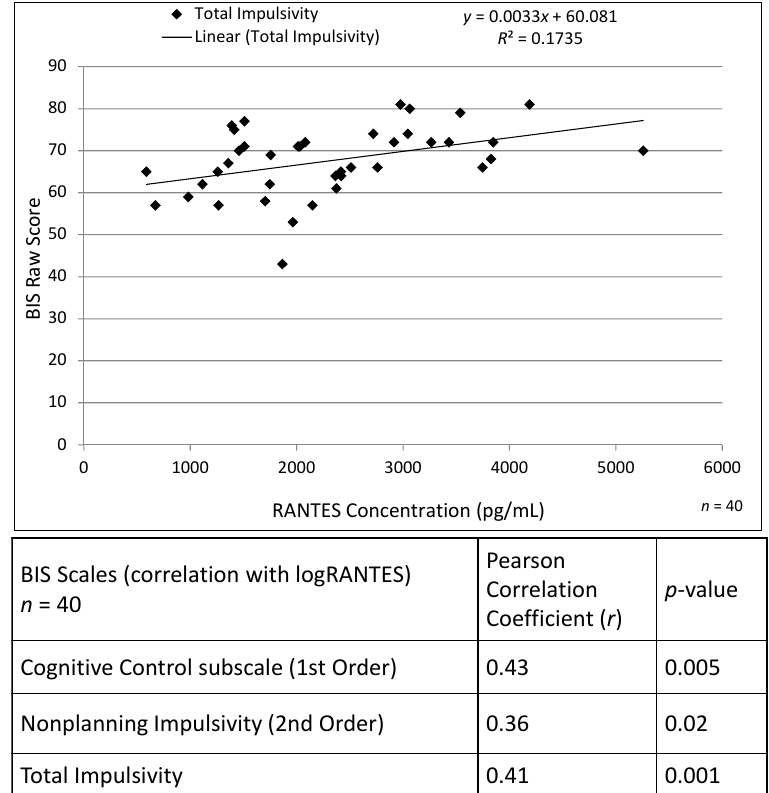
Figure 3. The scatter plot shows the relationship between plasma RANTES concentration and Barratt Impulsivity Raw Score for Total Impulsivity for n = 40 adult male African-American participants. A trendline indicates the strength of the linear correlation. The table provides Pearson correlation coefficients ( r ) between logRANTES and BIS subscales. Relationship between Plasma RANTES Levels and Barratt Impulsivity Scores in Males with Alcoholism. Table 1. Linear Regression model of logRANTES (regulated on activation, normal T cell expressed and secreted) on Barratt Impulsivity Scales (BIS) outcomes.